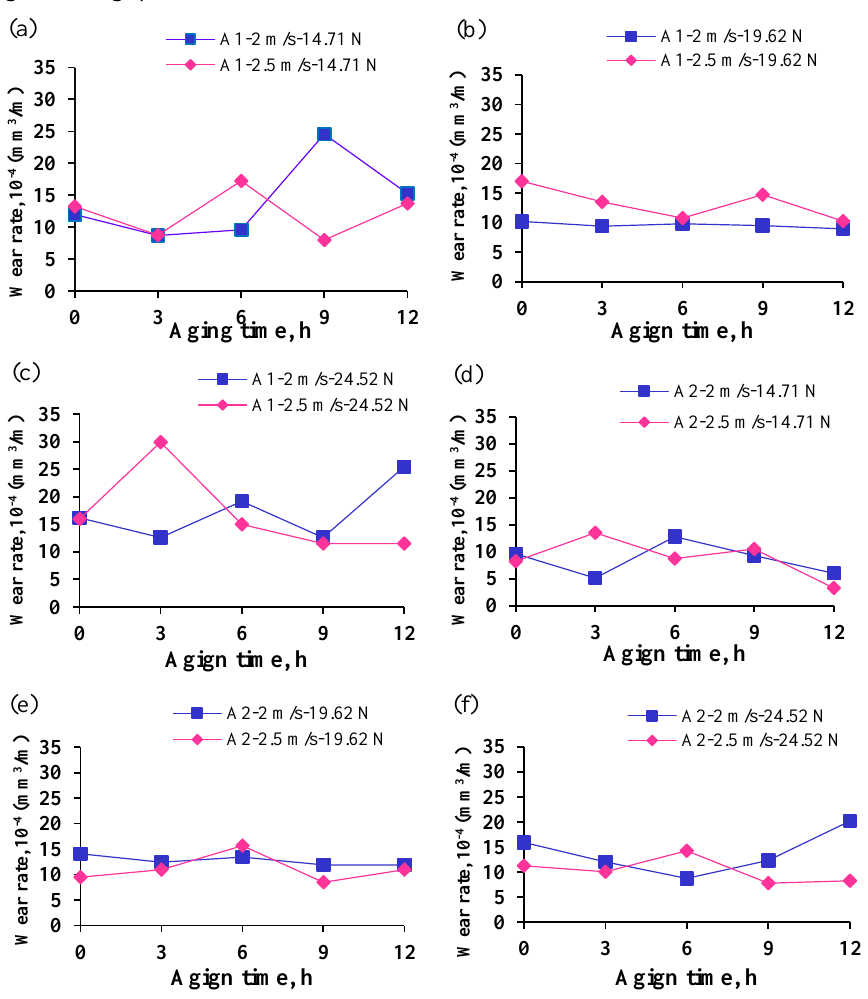
Fig. 7. (a), (b), (c), (d), (e), and (f) are the wear rate of base alloy (Al-Si-Mg – A1) and Composites (Al-Si-Mg/TiB 2 – A2) as a function of ageing time by varying sliding speed (2, 2.5 m/s) and normal applied load (14.71, 19.62, 24.52